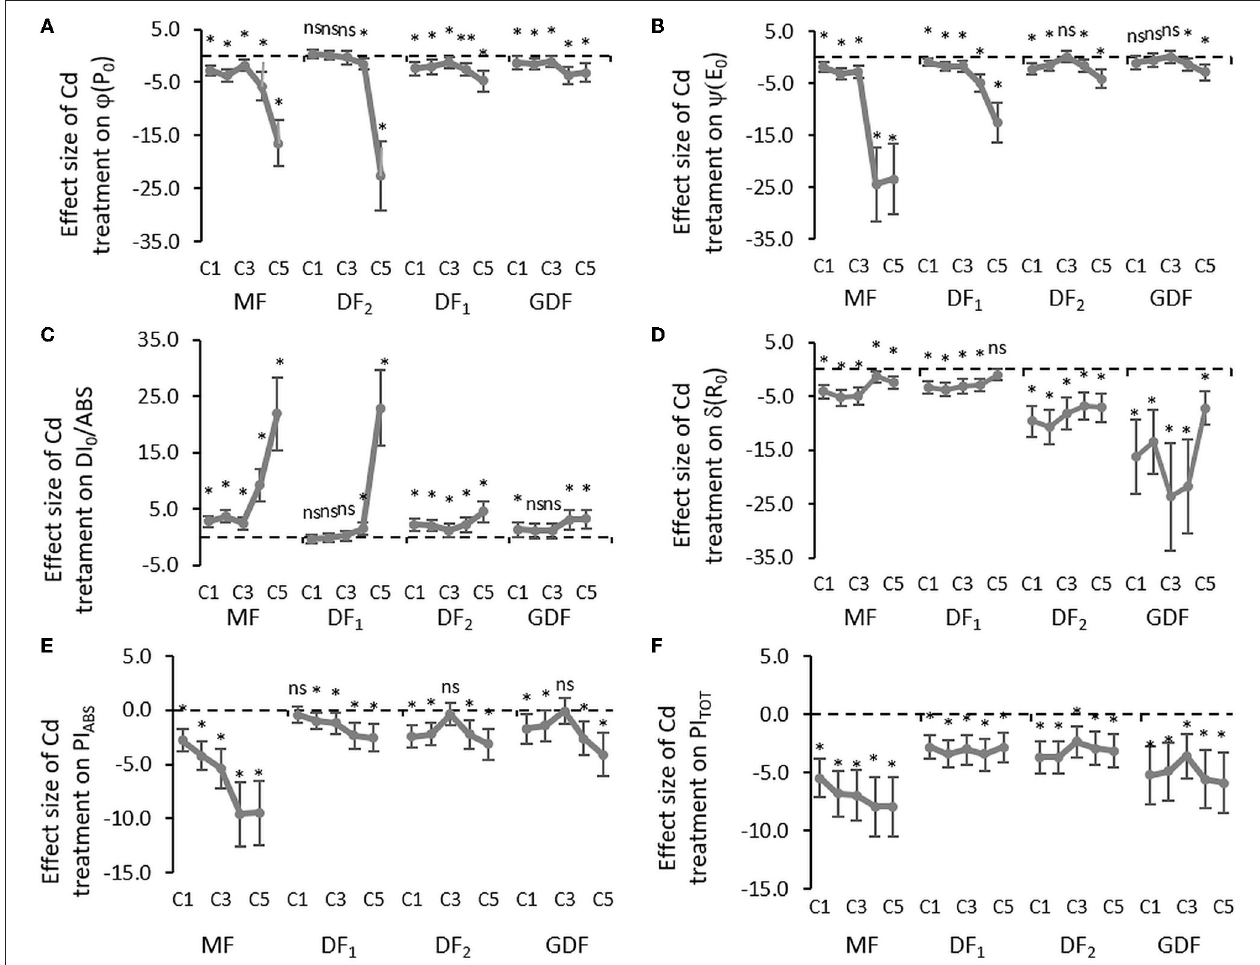
FIGURE 4 | Mean effect sizes (Hedges d) and bias-corrected bootstrap 95% confidence interval for the overall effect of Cd treatment on efficiencies and quantum yield: (A) the maximum quantum yield of primary PSII photochemistry that leads to QA reduction ( φ P 0 ), (B) the probability that a trapped exciton moves an electron into the electron transport chain beyond Q A ( ψ E 0 ), (C) quantum yield of energy dissipation in PSII antenna (DI 0 /ABS), (D) the efficiency that contains the rate constants for intersystem electron transport and reduction of the end-electron-acceptor ( δ R 0 ), (E) performance index (potential) for energy conservation from exciton to the reduction of intersystem electron acceptors, and (F) performance index (potential) for energy conservation from exciton to the reduction of PSI end acceptors. Effect sizes are based on mean differences between treatment and the control (C0) after 72 h of exposure to Cd concentration from 7 µ M–C1 to 111 µ M–C5. The dashed line shows Hedges d = 0. When confidence intervals overlap zero, the effect sizes are not significantly different from zero ( p -value for mean difference is obtained by 2-tailed t -test, ns for p > 0.05; * p <